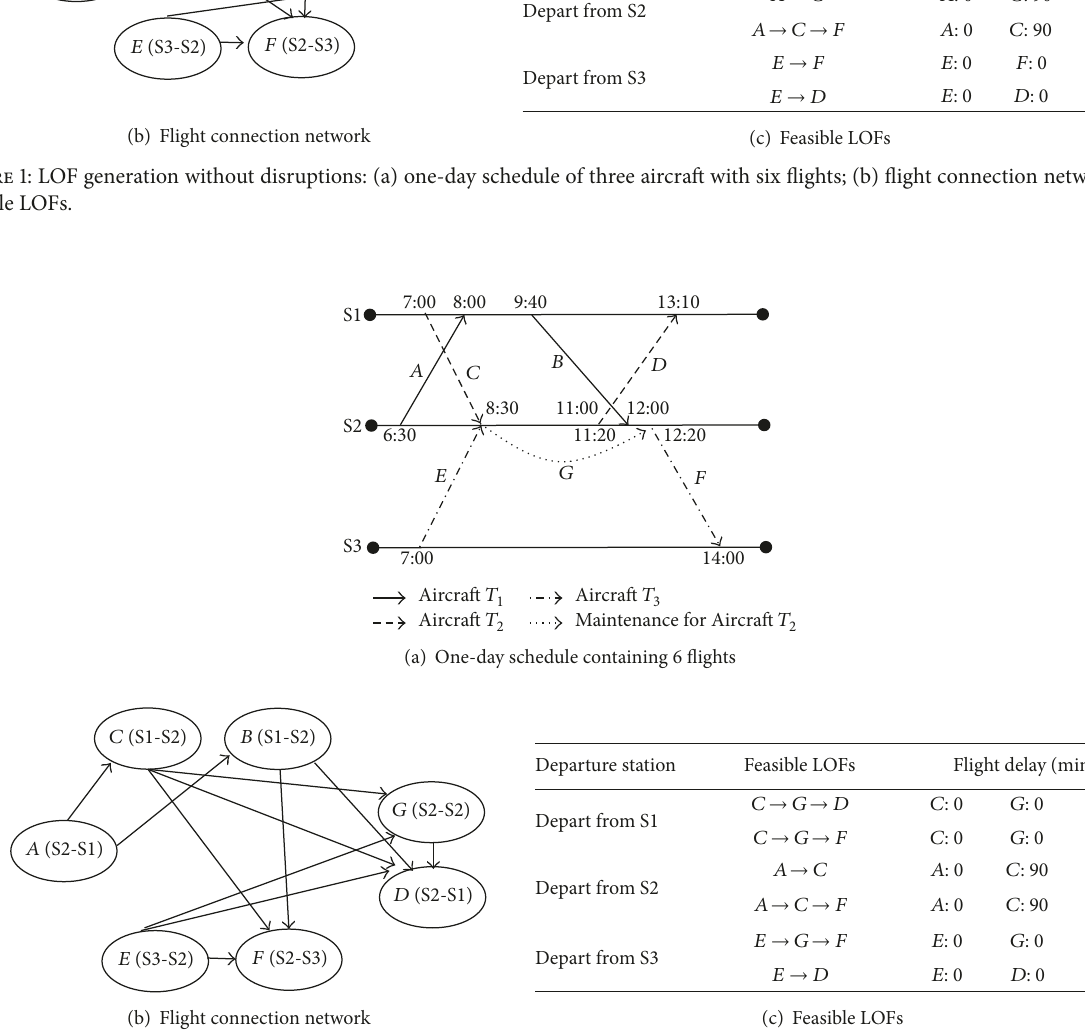
Figure 2: LOF generation with aircraft disruptions: (a) one-day schedule of three aircraft with six flights and one maintenance; (b) flight connection network; and (c) feasible